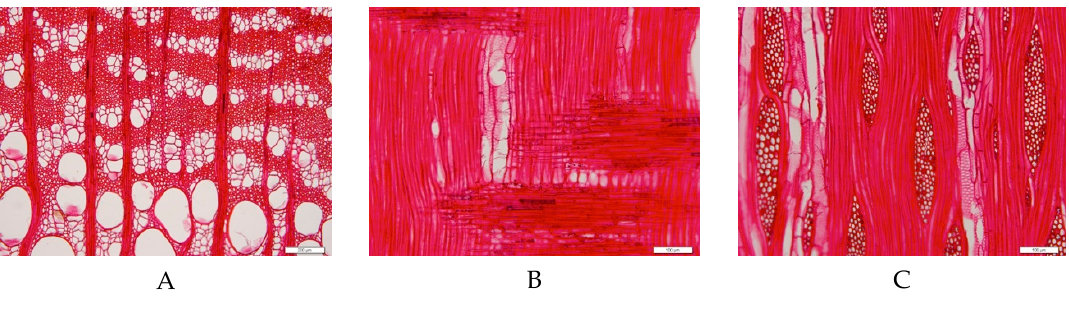
Figure 4. Microstructure of elm wood. ( A ) Transverse section; ( B ) radial section; and ( C ) tangential section.